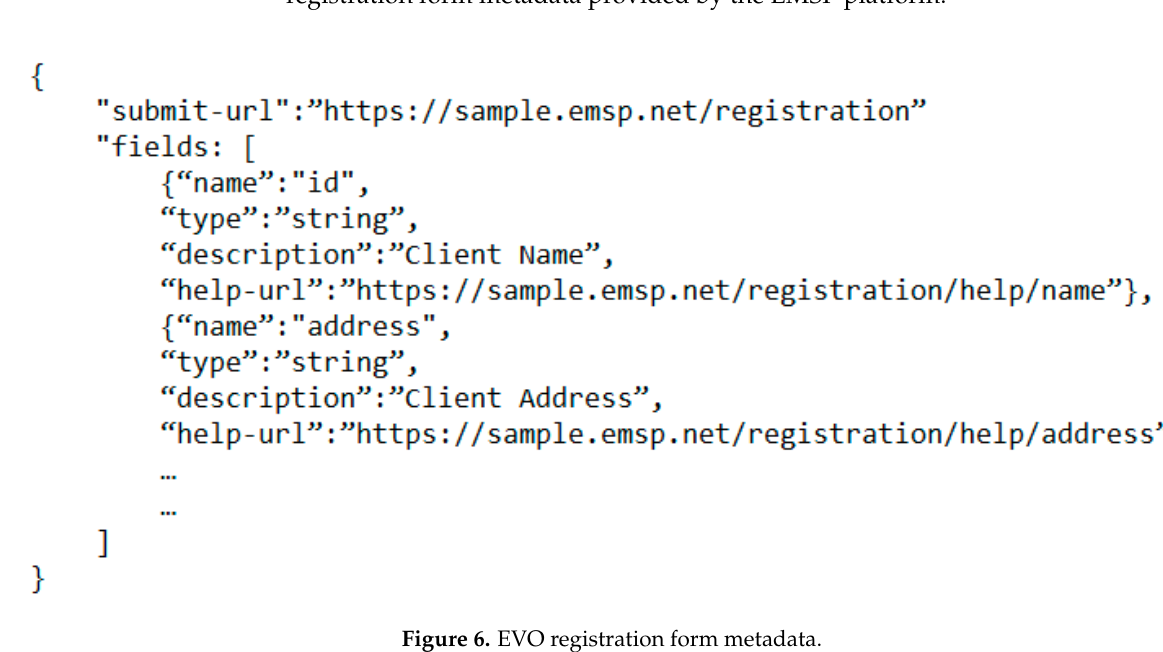
Figure 6. EVO registration form metadata.